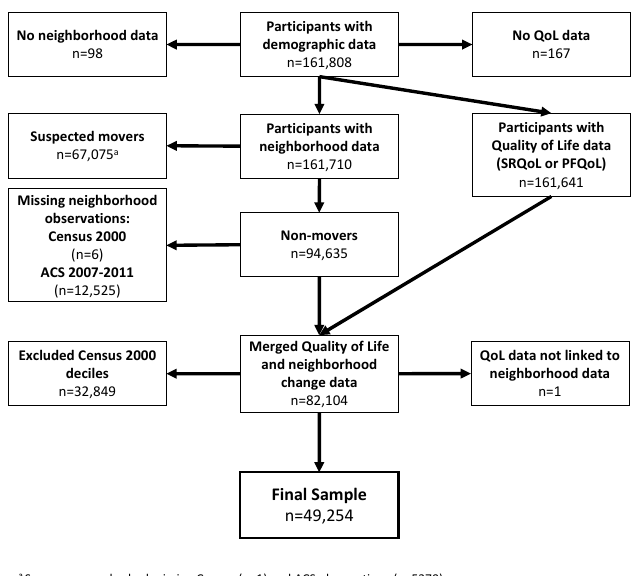
Figure 3. Participant flow diagram.